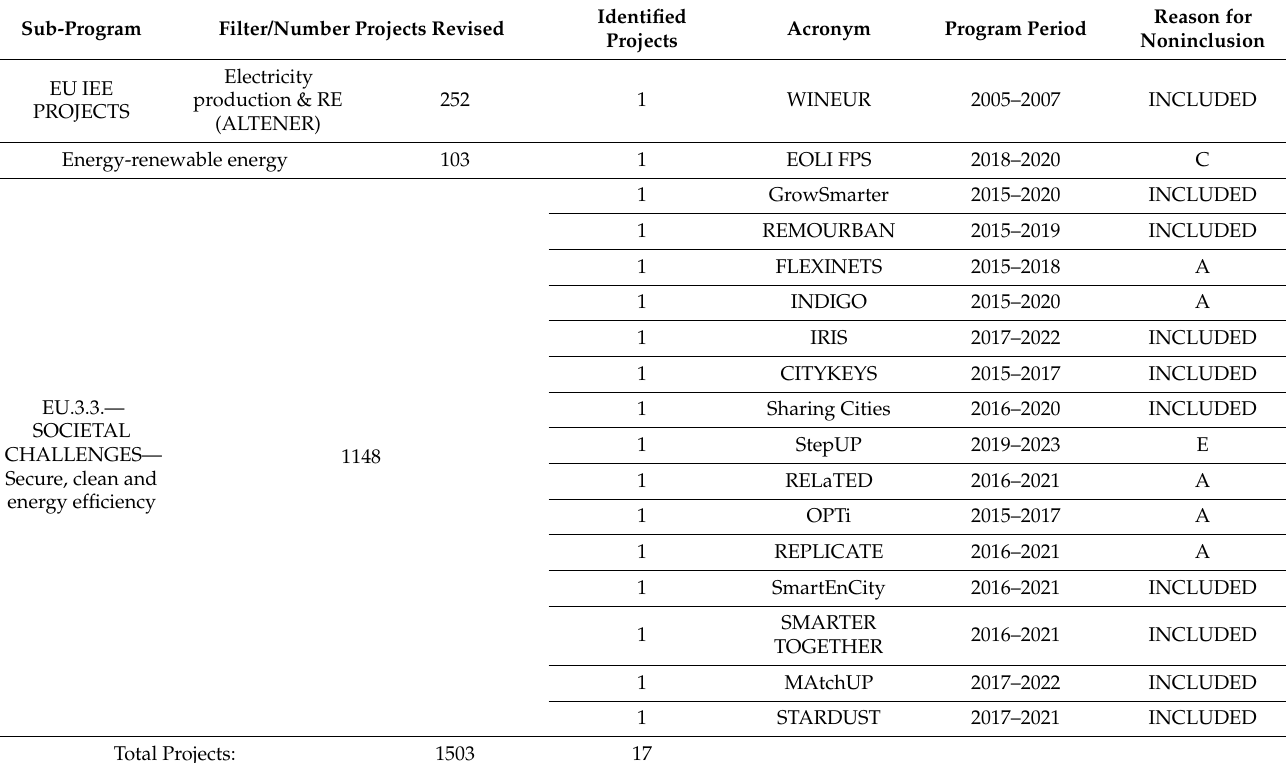
Table 4. Results for projects corresponding to the H2020